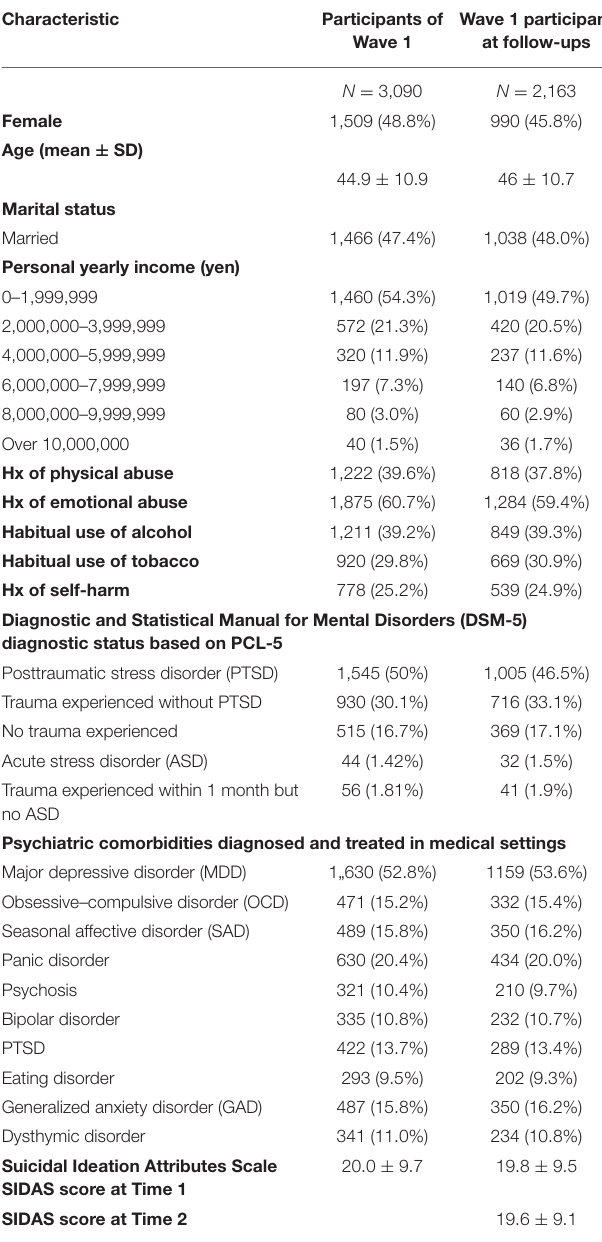
TABLE 1 | Characteristics of the study